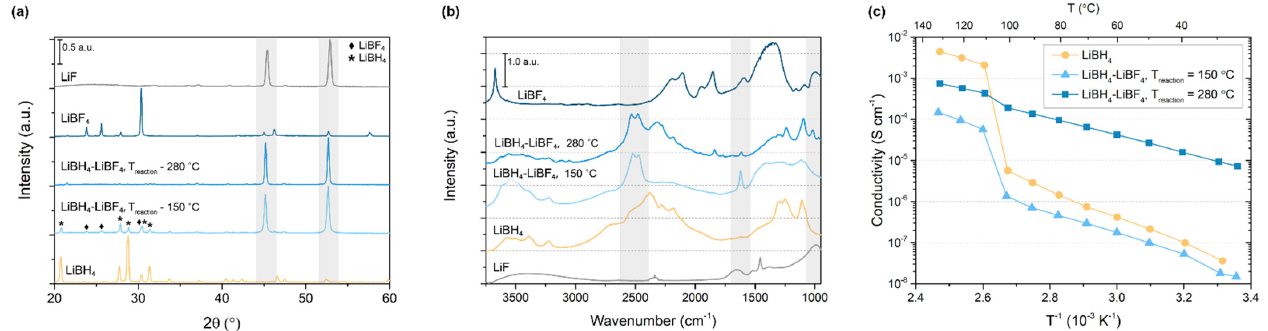
Figure 1. ( a ) X-ray powder diffraction patterns, ( b ) DRIFTS spectra and ( c ) Arrhenius conductivity plots of LiBH 4 -LiBF 4 mixtures prepared at 150 °C and 280 °C. For comparison, LiBH 4 , LiBF 4 and LiF are included in the XRD patterns; the spectra of LiBH 4 , LiBF 4 and LiF are shown in the DRIFTS spectra and the ionic conductivity of pristine LiBH 4 is added to the Arrhenius plots. Relevant reflections are highlighted in grey.